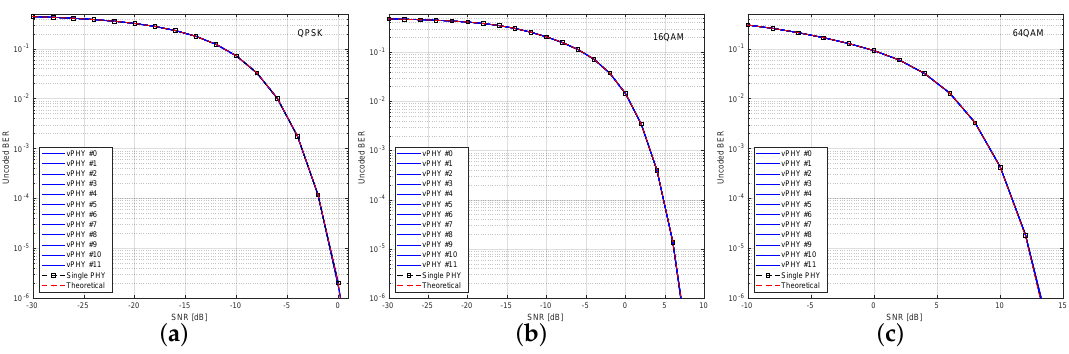
Figure 14. BER curves for a setup where 12 vPHYs concurrently have their signals multiplexed by the hypervisor and use: ( a ) QPSK, ( b ) 16QAM and ( c ) 64QAM modulation